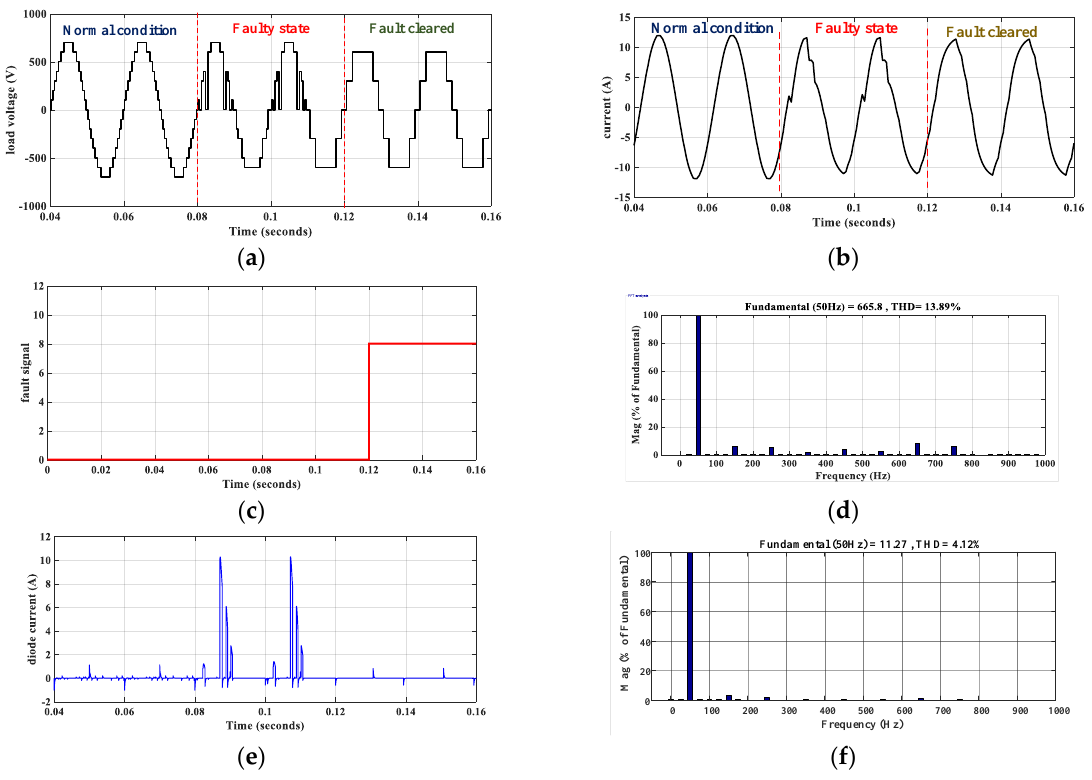
Figure 6. Simulation results for S8 fault for ( a ) load voltage, ( b ) load current, ( c ) fault detection signal, ( d ) voltage harmonics profile, ( e ) diode current, and ( f ) current harmonics profile.